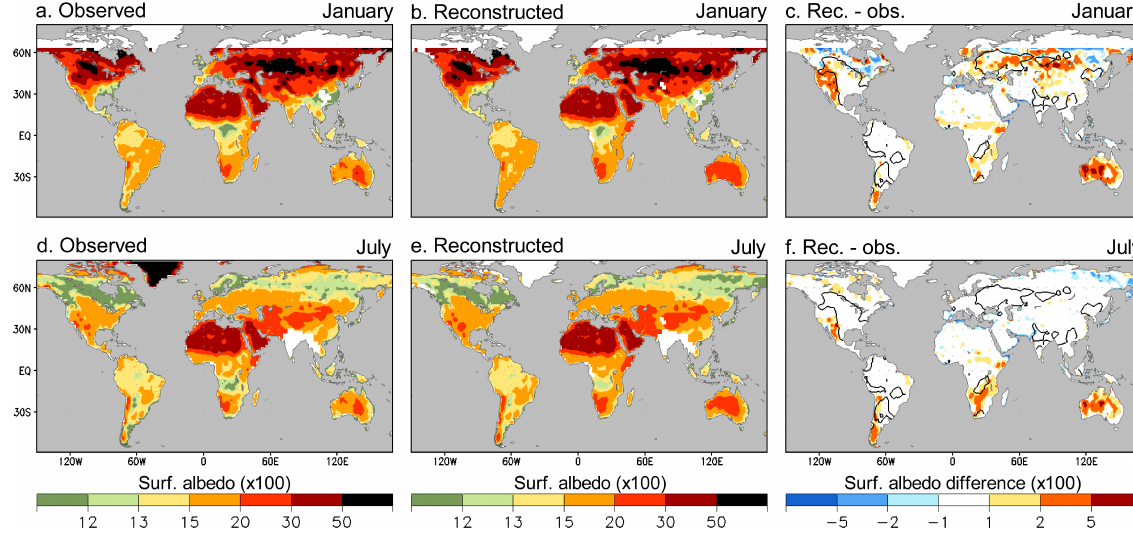
Fig. 3. Mean surface albedo in January (top) and July (bottom) based on MODIS (2000–2011) observations (a) , (d) and reconstructions (b) , (e) . Difference between the reconstructed and the observed albedo (c) , (f) . Solid contours encompass regions with large LCC between 1870 and 1992 (areal fraction deforested larger than 10%; see Fig. 5). Note the non-linear scale.